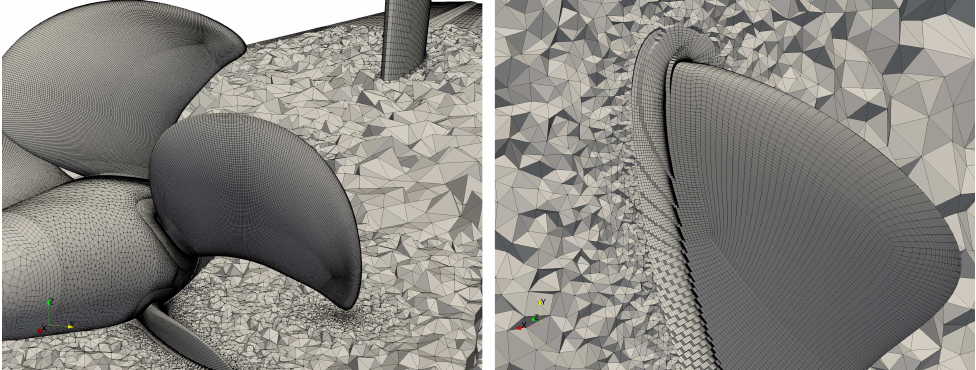
Figure 3. Close-up view at the blade surface mesh and tip volume